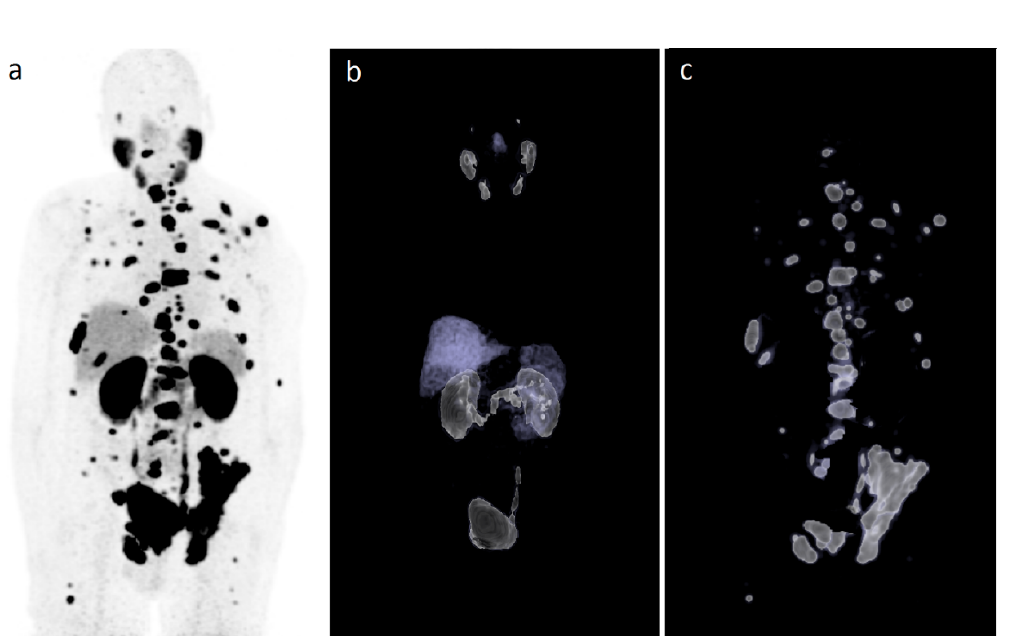
Figure 2. Illustration of the selected sites by the Syngo.via-software. ( a ) [ 68 Ga]Ga-PSMA-11 PET/CT maximum intensity projection (MIP) of a patient with metastatic prostate cancer; ( b ) volume rendering technique (VRT) of the same patient’s [ 68 Ga]Ga-PSMA-11 PET/CT showing only the healthy tissue PSMA uptake; ( c ) VRT of the same patient’s [ 68 Ga]Ga-PSMA-11 PET/CT with the selected tumor sites by the Syngo.via-software including lymph nodes, bone, and visceral lesions, after manual deletion of healthy tissues PSMA uptake as shown in ( b ).